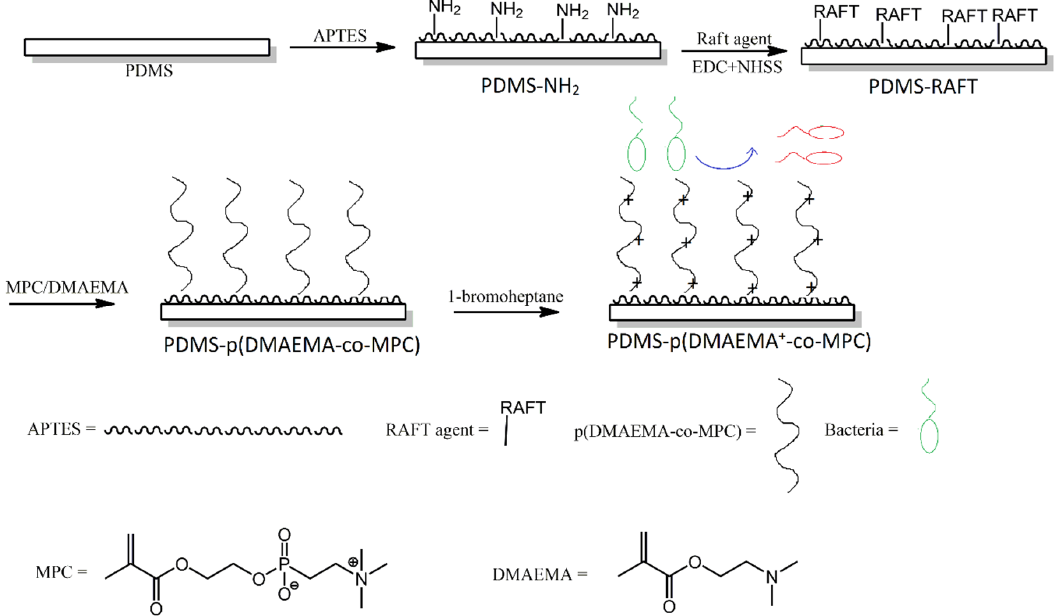
Figure 9. Schematic illustration of the preparation of p(DMAEMA + -co-MPc) copolymer brushes on poly (dimethylsiloxane) (PDMS) with nonfouling and bactericidal properties. Abbreviations: p(DMAEMA + -co-MPc) = (2-(dimethylamino)-ethyl methacrylate-co-2-methacryloyloxyethyl phosphorylcholine; APTES = (3-aminopropyl)triethoxysilane; EDC = N-(3-dimethylaminopropyl)-N’- ethylcarbodiimide hydrochloride; NHSS = N-hydroxysulfosuccinimide sodium salt. Based on Ref. [26].